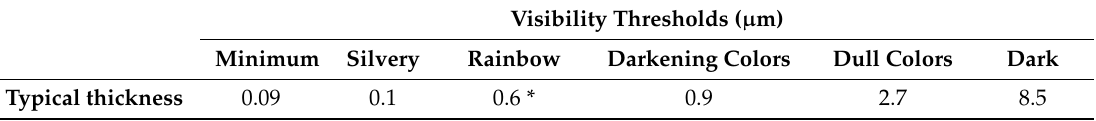
Table 3. ASTM Relationship of Thickness to Appearance.